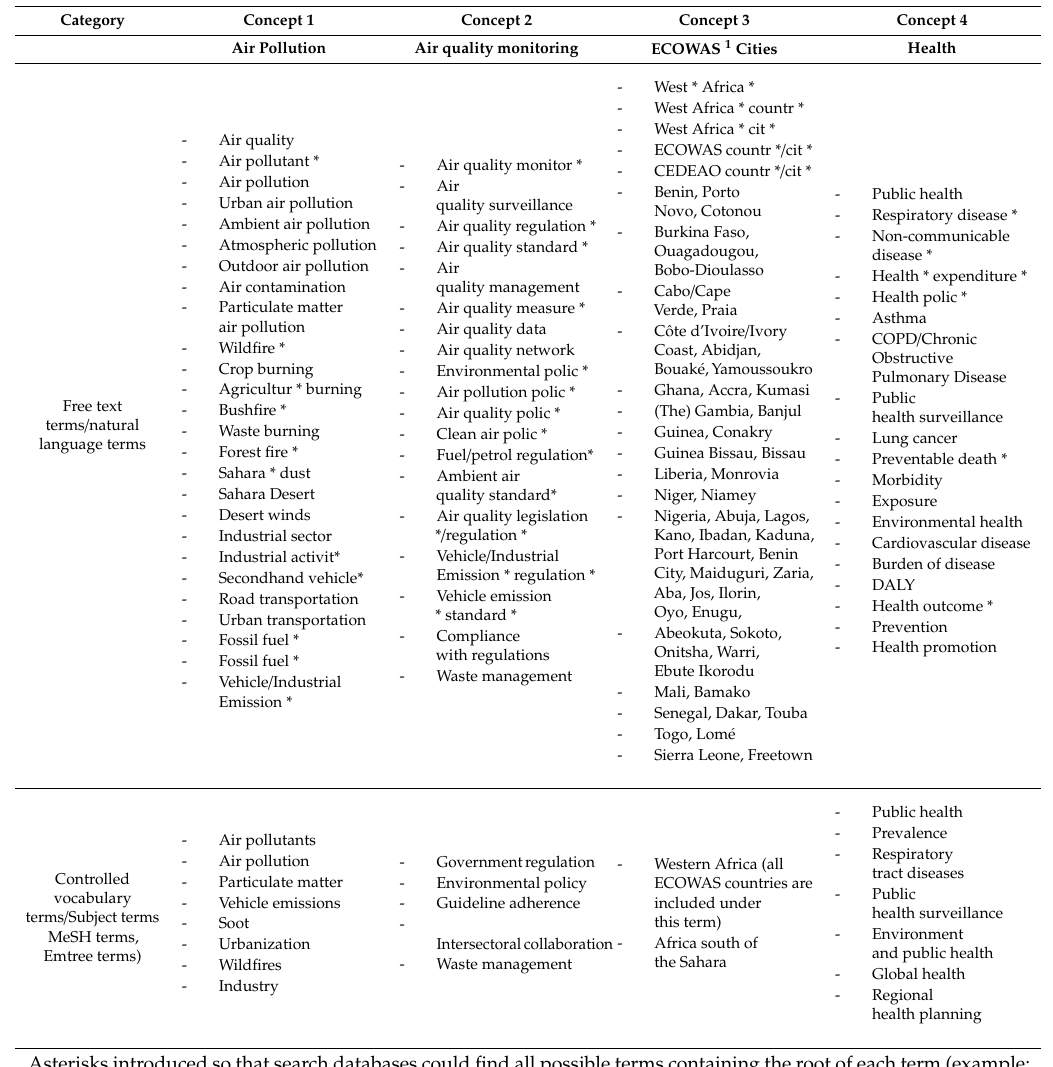
Table A1. Full list of search